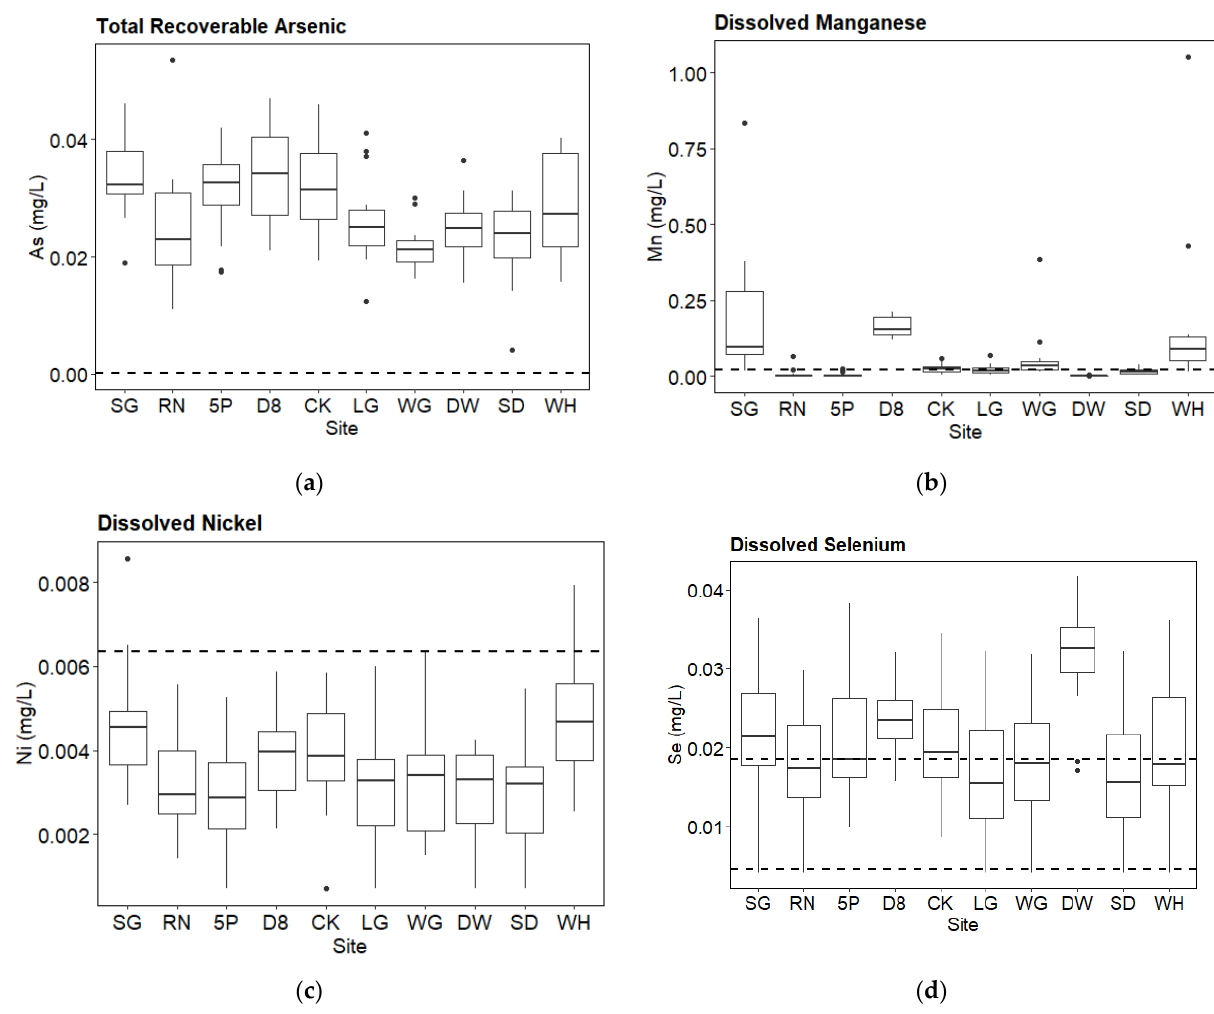
Figure 4. Metals that exceeded CDPHE standards were total As, dissolved Mn, dissolved Ni, and dissolved Se: ( a ) Boxplot results with the chronic CDPHE standard for total As. ( b ) Boxplot results with the chronic CDPHE standard for dissolved Mn. ( c ) Boxplot results with the chronic CDPHE standard for dissolved Ni. ( d ) Boxplot results with the acute and chronic CDPHE standards (acute standard was higher than chronic) for dissolved Se.